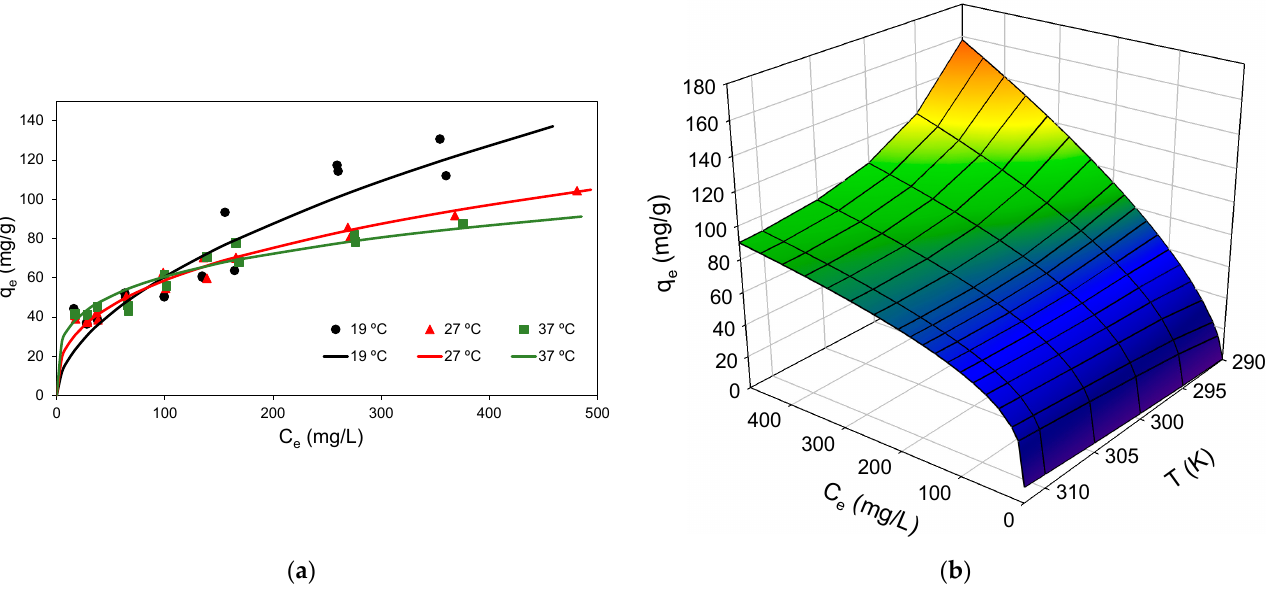
Figure 3. ( a ): Freundlich isotherm for Ag(I) biosorption by Rhodotorula mucilaginosa 1S1 at three temperatures and ( b ): response surface graph for the factors studied.